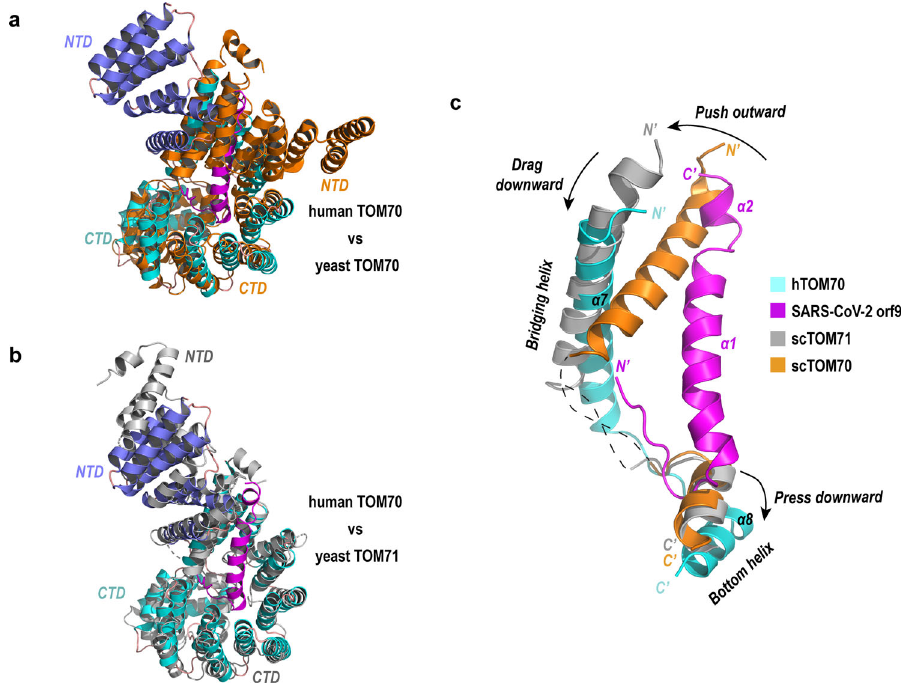
Fig. 3 Orf9b binding induced conformational rearrangement. a Superimposition of the hTOM70/SARS-CoV-2 orf9b complex with yeast TOM70 (PDB id: 2GW1). The NTD of hTOM70 is colored blue, the CTD is colored cyan. SARS-CoV-2 orf9b is colored magenta. b Superimposition of the hTOM70/SARS- CoV-2 orf9b complex with yeast TOM71 (PDB id: 3FP3). hTOM70 and SARS-CoV-2 orf9b are colored as in panel a . c Superimposition of the hTOM70/ SARS-CoV-2 orf9b complex with yeast TOM70 and TOM71. Only the bridging helices and the bottom helices are shown to illustrate conformational rearrangement induced by SARS-CoV-2 orf9b